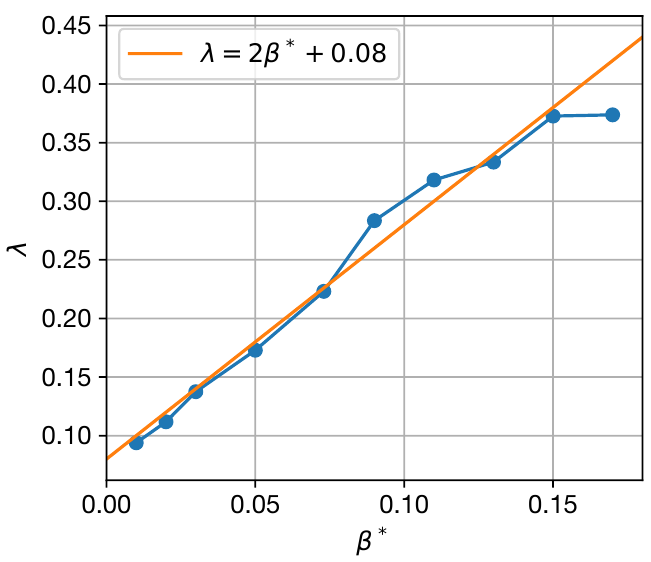
Figure 6. Coherent eddy decay rate, λ , in units of inverse turnover time as a function of β (cid:63) (blue). The orange line gives λ = 2 β ∗ + 0.08. The decay rate is obtained from exponential fits to the number of 30-, 60-, and 90-day eddies for each value of β (cid:63)